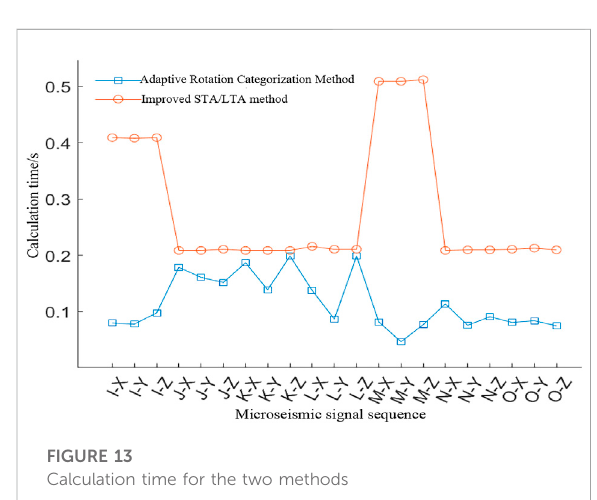
FIGURE 13 Calculation time for the two methods